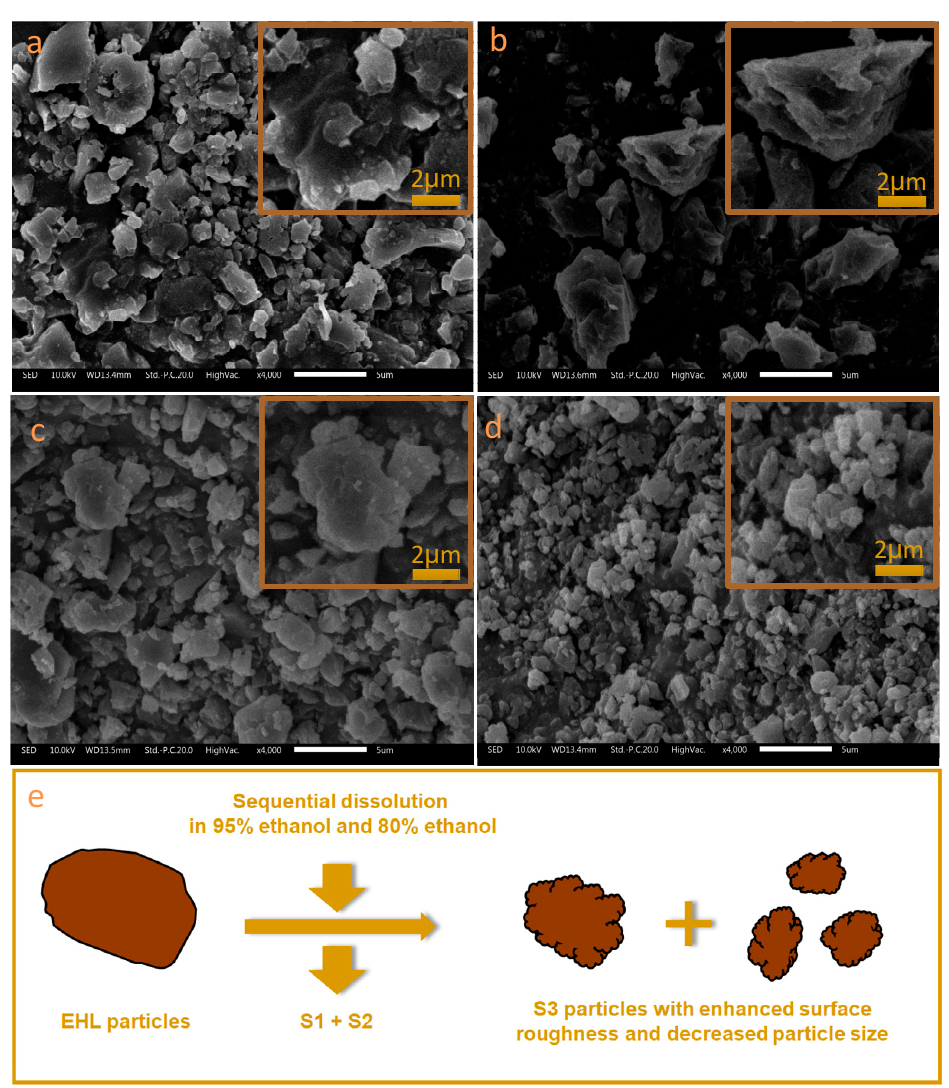
Figure 3. Scanning electron microscopy (SEM) images of EHL ( a ), S1 ( b ), S2 ( c ), and S3 ( d ). The scale bar for the SEM images is 5 μ m. Schematic showing morphological changes from EHL particles to the 80% ethanol insoluble subdivision (S3) particles ( e ).